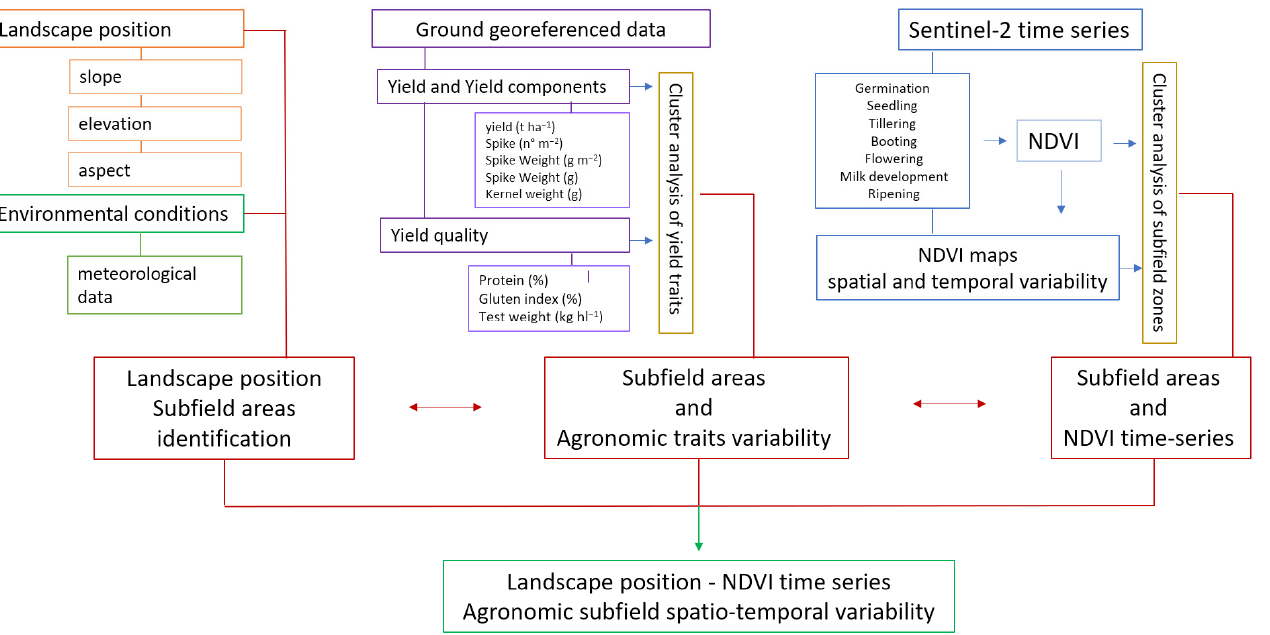
Figure 2. Flowchart of the proposed method to assess the agronomic subfield variability by Sentinel-2 NDVI time-series and landscape position.